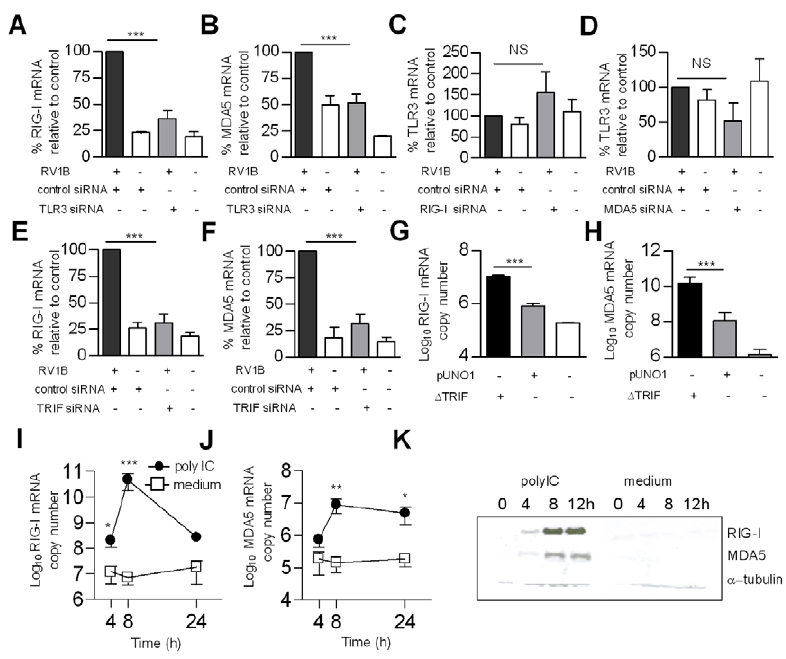
Figure 7. Role of TLR3 and TRIF in RV1B induced RIG-I and MDA5 expression. HBECs were transfected with siRNA specific for TLR3 or control siRNA (A,B) RIG-I or control siRNA (C) or MDA5 or control siRNA (D), TRIF or control siRNA (E,F) infected with RV1B, and RIG-1 (A,E), MDA5 (B,F) or TLR3 mRNA (C,D) measured at 24 h. HBECs were transfected with D TRIF or pUNO1 plasmids, or were left untransfected, and RIG-I (G) and MDA5 mRNA (H) measured 24 h post transfection. HBECs were treated with the TLR3 ligand polyIC or medium and RIG-I (I) and MDA5 mRNA (J) measured at various time points, or RIG-I and MDA5 protein assessed by western blotting over time (K). * p , 0.05, ** p , 0.01, *** p , 0.001 versus control siRNA, pUNO1, or medium treated cells, NS=not significant. mRNA data was generated from 5 independent experiments utilizing 3 independent HBEC donors, 2 experiments per donors 1,2 one experiment for donor 3.